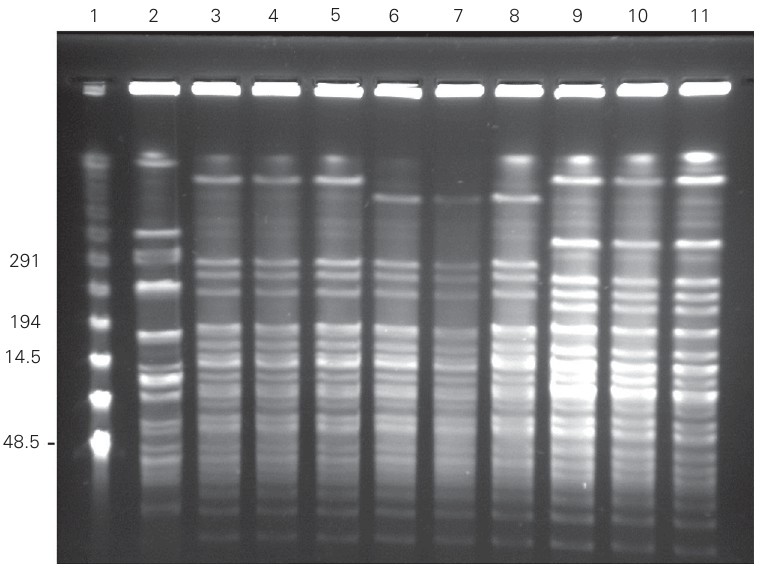
Figure 1. PFGE of Enterococcus faecalis. Lane 1 , Molecular weight lambda ladder size marker (kb); lane 2 , E. faecalis ATCC 29212; lanes 3 to 5 , vancomycin-resistant E. faecalis